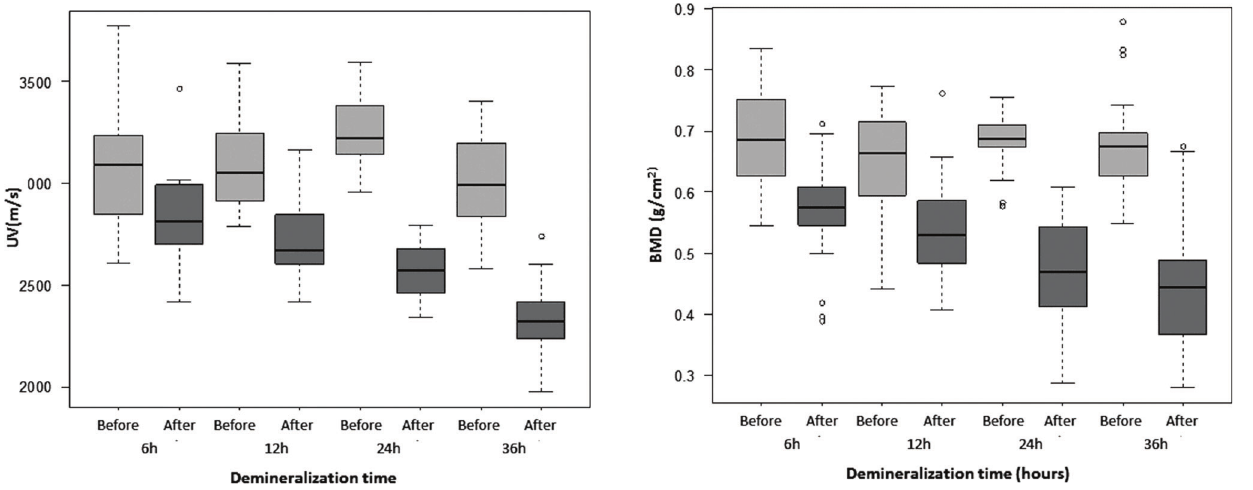
Figure 6 - Box-plot graph of the bone mineral density (BMD) before (light grey boxes) and after (dark grey boxes) deminer- alization, according to demineralization